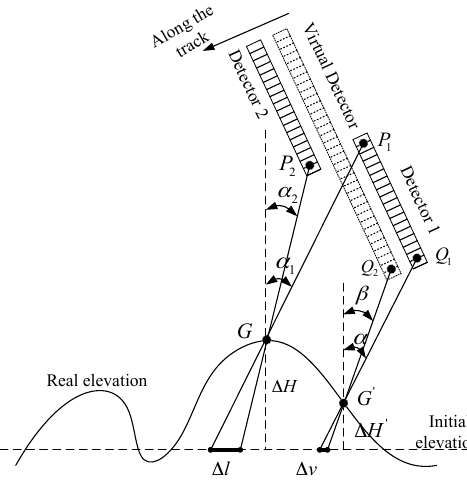
Figure 4. The influence of the elevation error.